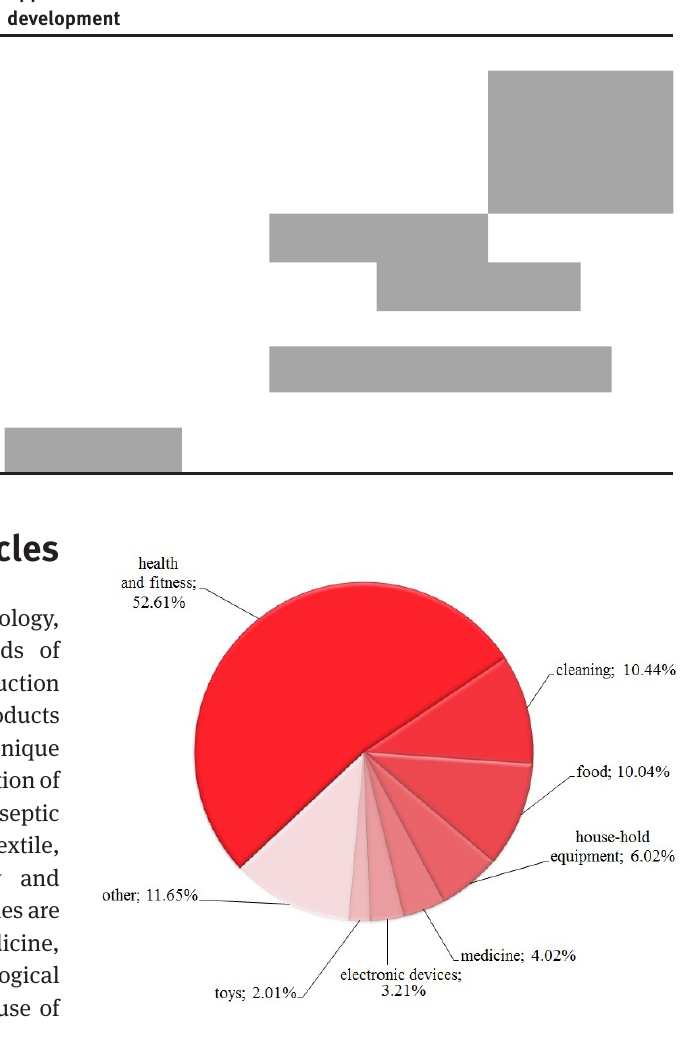
Figure 2: Categories of products containing silver nanoparticles